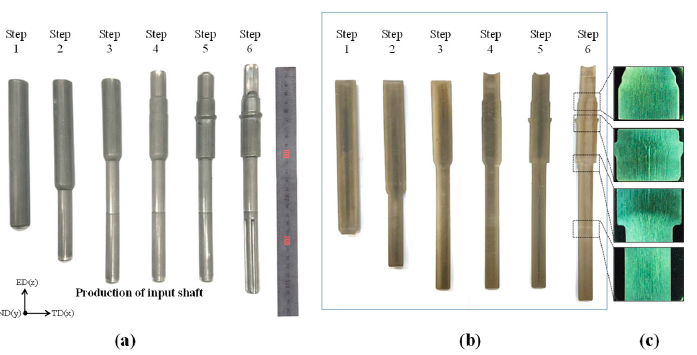
Figure 7. View of the ( a ) surface of the product, ( b ) interior of the product, and ( c ) metal flow of the produced